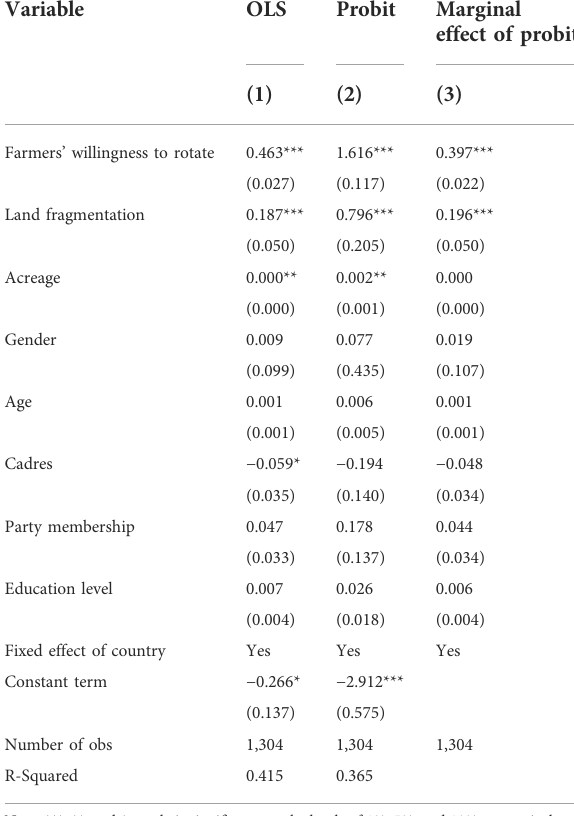
TABLE 3 Estimation resultsof land fragmentation on farmers ’ rotation behavior. Variable